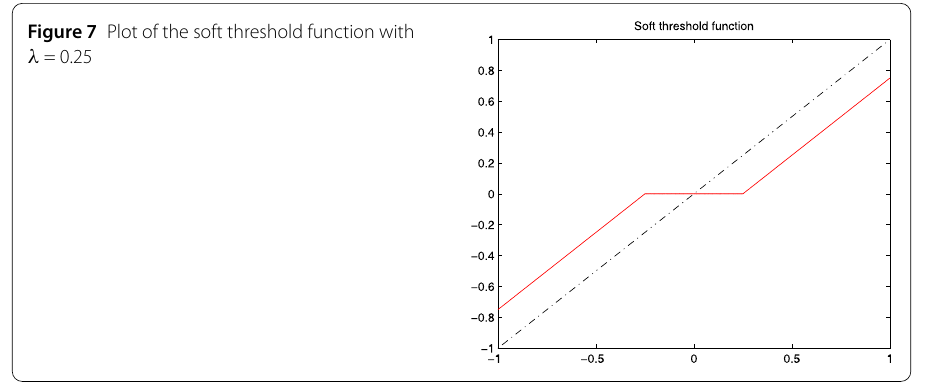
Figure 7 Plot of the soft threshold function with λ =